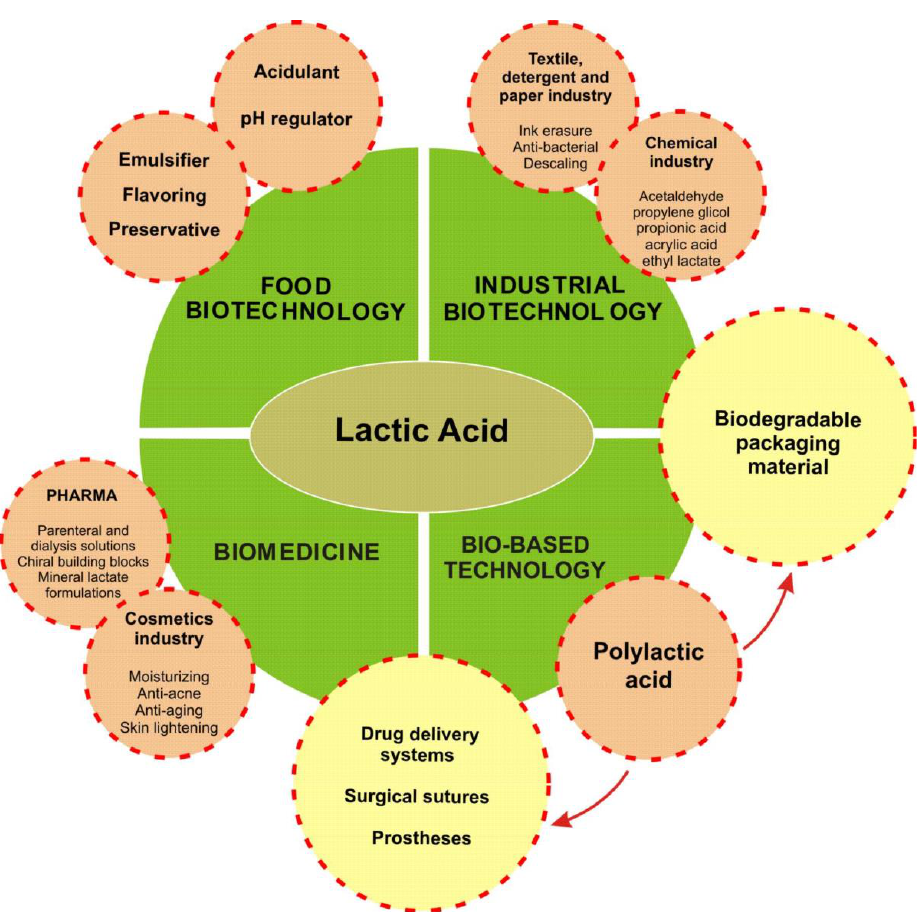
Figure 1. A wide range of biotechnological applications of lactic acid (Data from Balla et al. (2021) [7], Jem et al. (2020) [8], Maleki et al. (2022) [9], and Maleki et al. (2022) [10]).